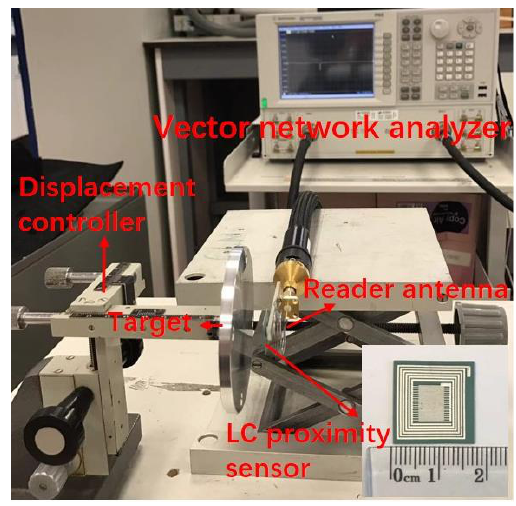
Figure 3. Measurement setup for the LC proximity sensor.